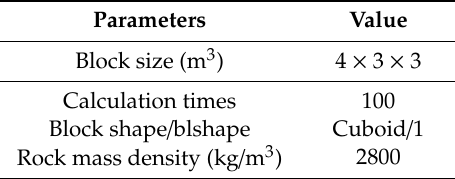
Table 2. Parameters of unstable rock masses.